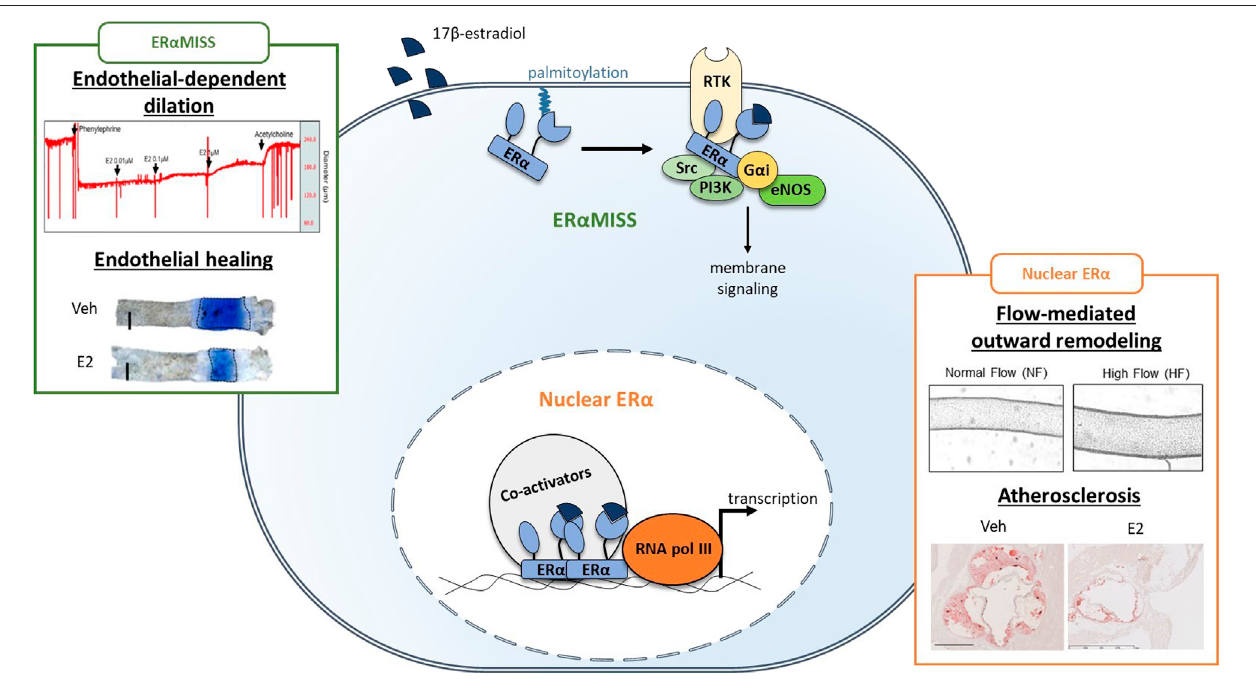
FIGURE 3 | Respective role of ER α MISS and nuclear ER α in E2-mediated vascular protection in endothelial cells. Fixation of 17 β -estradiol (E2) triggers conformationalchangesinER α structure,leadingtotherecruitmentofco-activators.Co-activatorsfacilitateER α bindingtoDNAandtherecruitmentofRNApolymerase (RNA pol III) which initiates transcription. In addition, ER α can localise to the plasma membrane after palmitoylation and mediates rapid membrane-initiated steroid signaling(ER α MISS)byinteractingwithdifferentsignalingpathwaysuchasGprotein,SRC,PI3KandeNOS.NOproductionandaccelerationofendothelialhealing in response to E2 depend on ER α MISS, while fl ow-mediated outward remodeling and prevention of atherosclerosis depend on nuclear ER α . Adapted from Guivarc ’ h et al. (2018), Adlanmerini et al. (2020), Zahreddine et al. (2020).